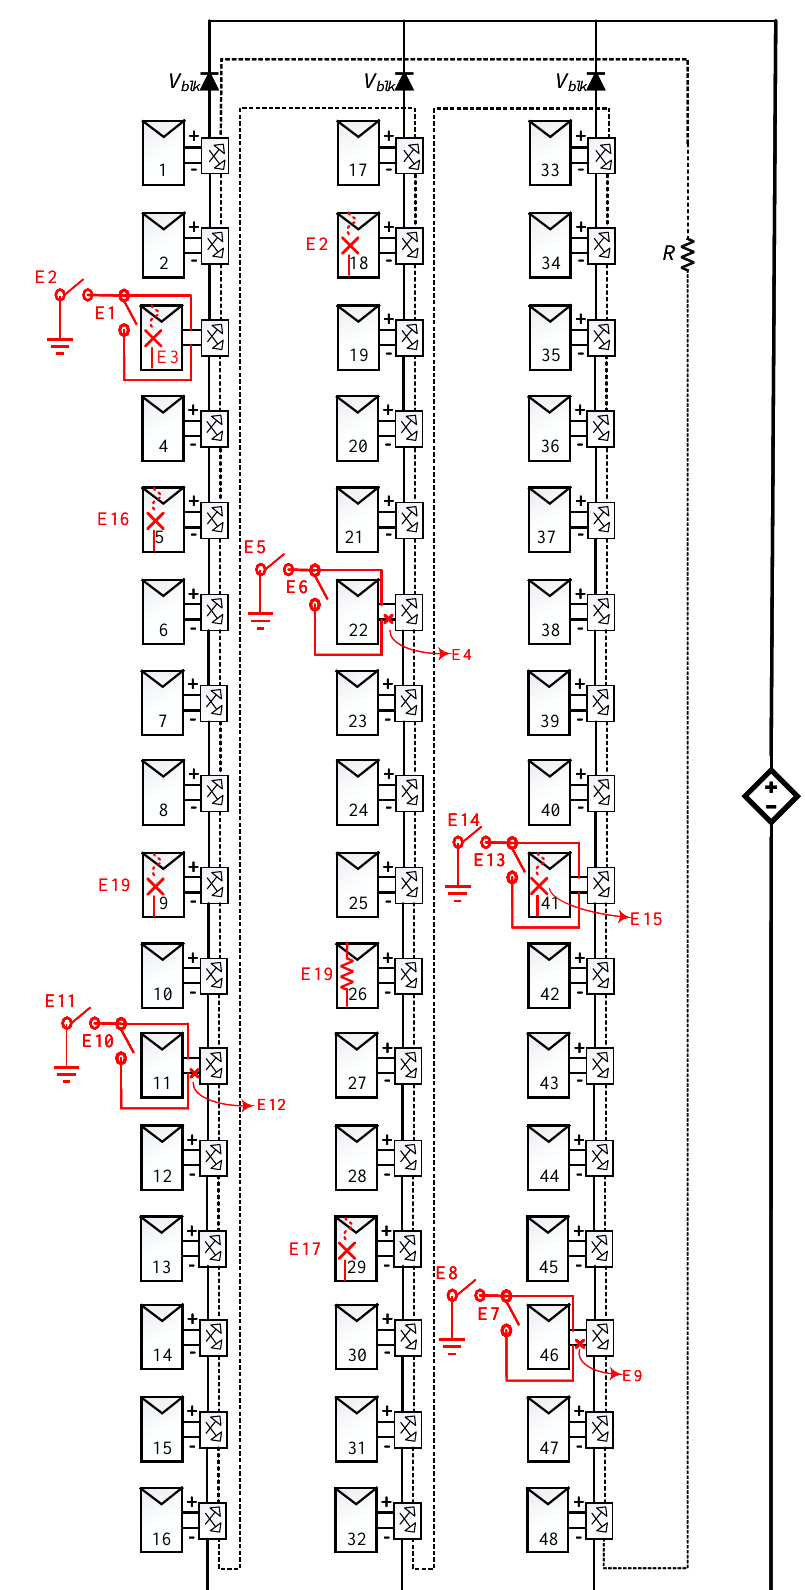
Figure 7. Location of the fault events inside the PV